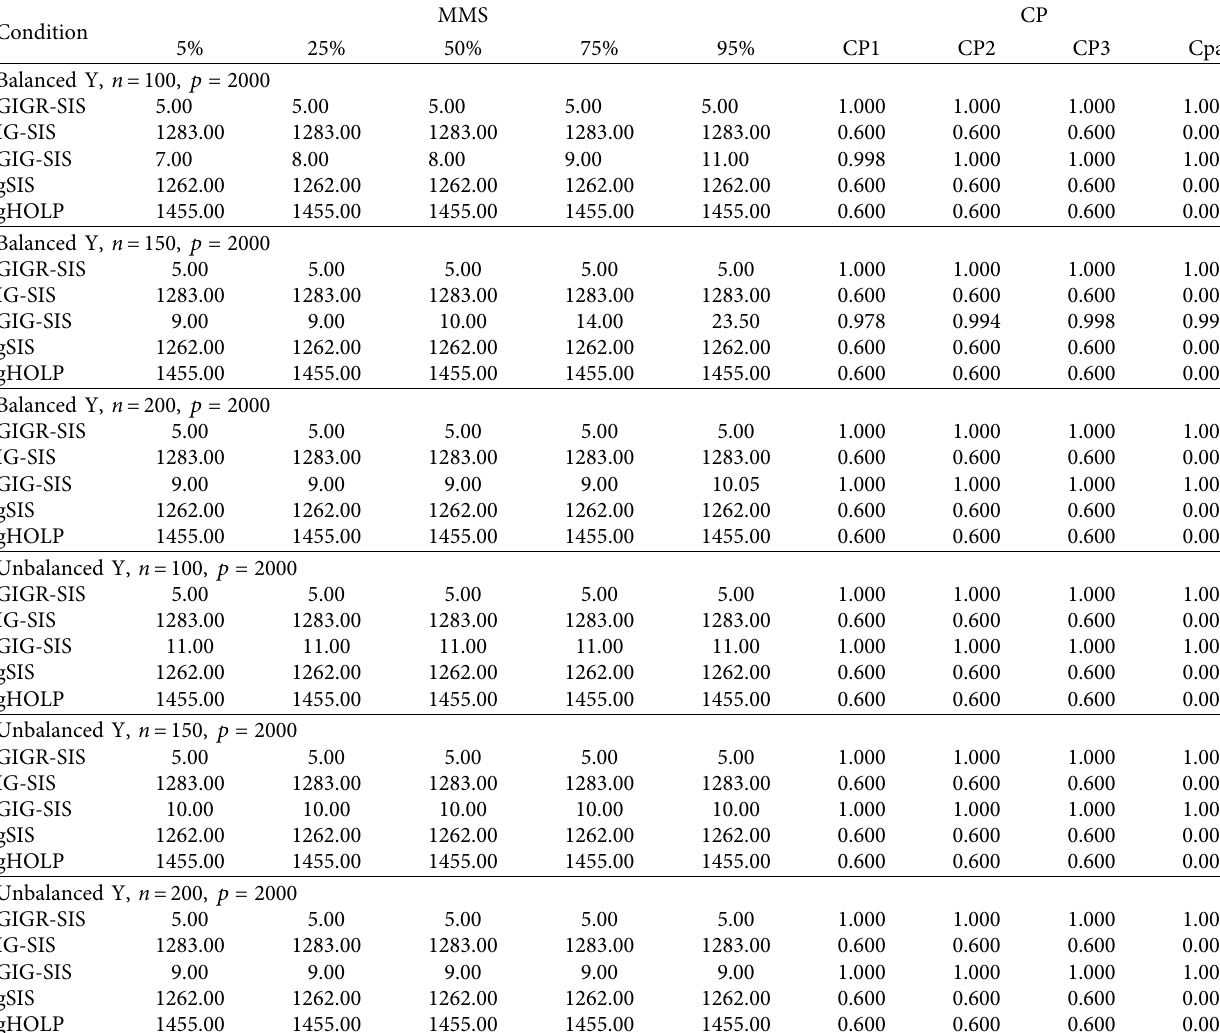
Table 2: Simulation results for Model 2.